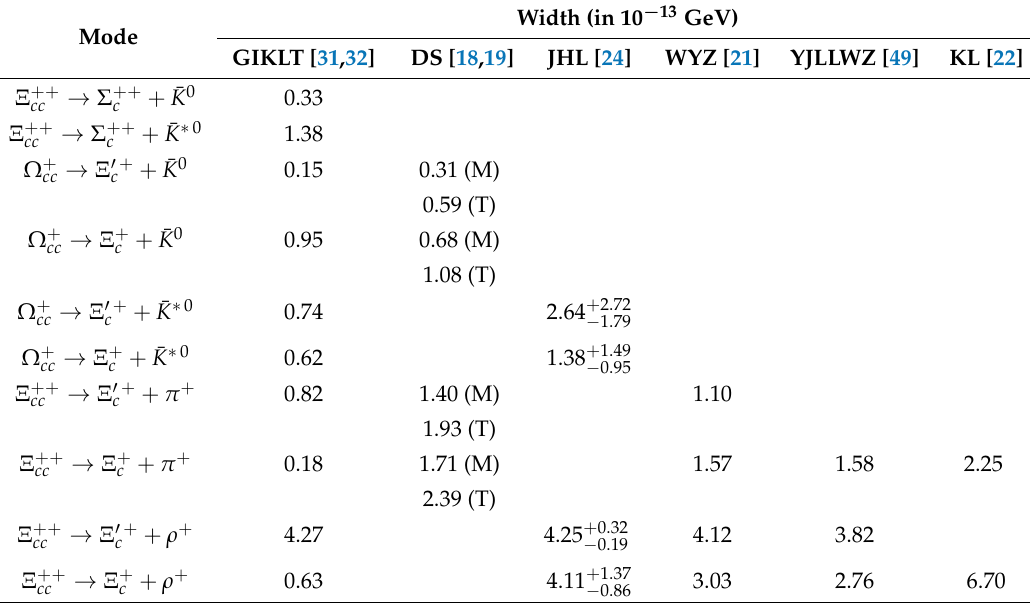
Table 8. Comparison with other approaches. Abbreviation: M = NRQM, T = HQET.